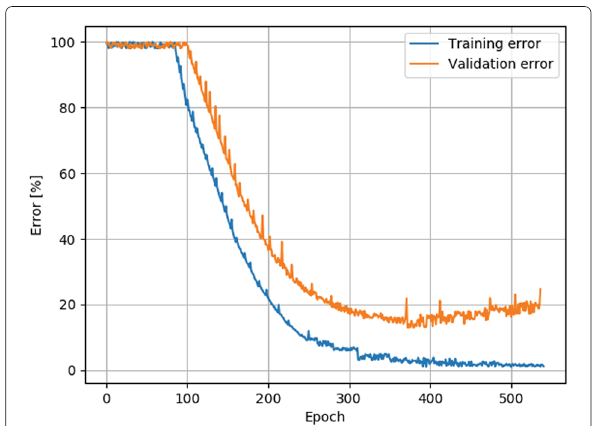
Fig. 5 Training process of traditional approach. Error rate during the traditional approach training